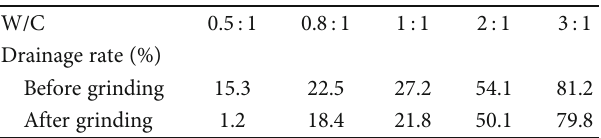
Table 4: Relationship between water-cement ratio (W/C) and water drainage